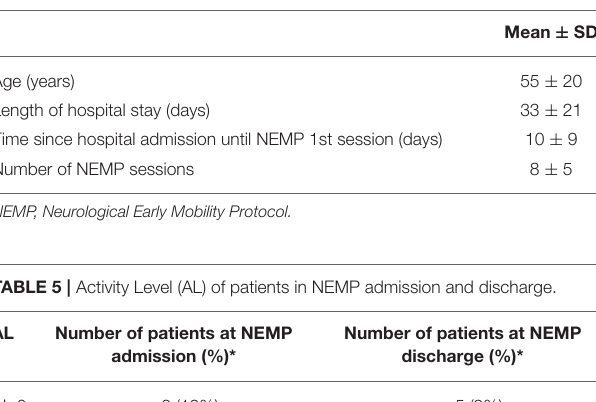
TABLE 2 | Scores from HPMQ recoded in ICF performance qualifier.